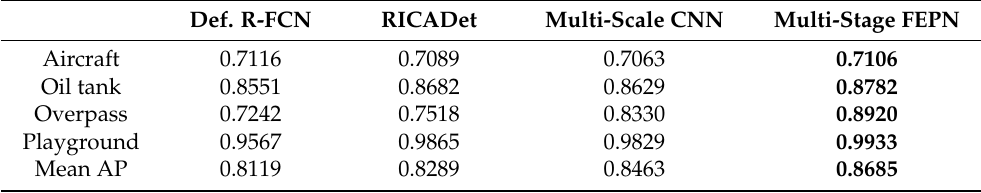
Table 6. The APs for each category and the mAP of different frameworks on